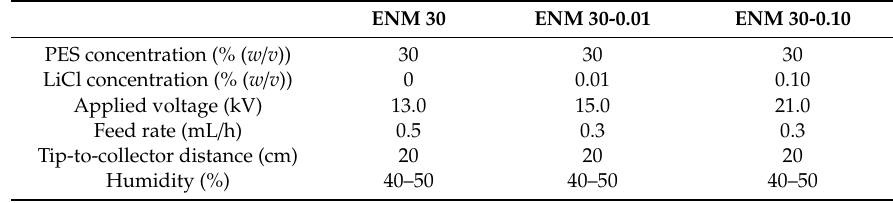
Table 1. Fabrication conditions of the three di ff erent polyethersulfone (PES) electrospun nanofibrous membranes